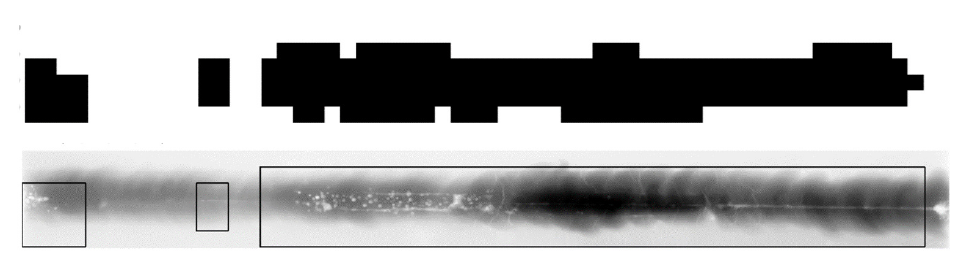
Figure 7. The detected defect regions, which are illustrated as black regions in the binary image ( top photo) and illustrated using the bounding boxes and overlaid on the original image ( bottom